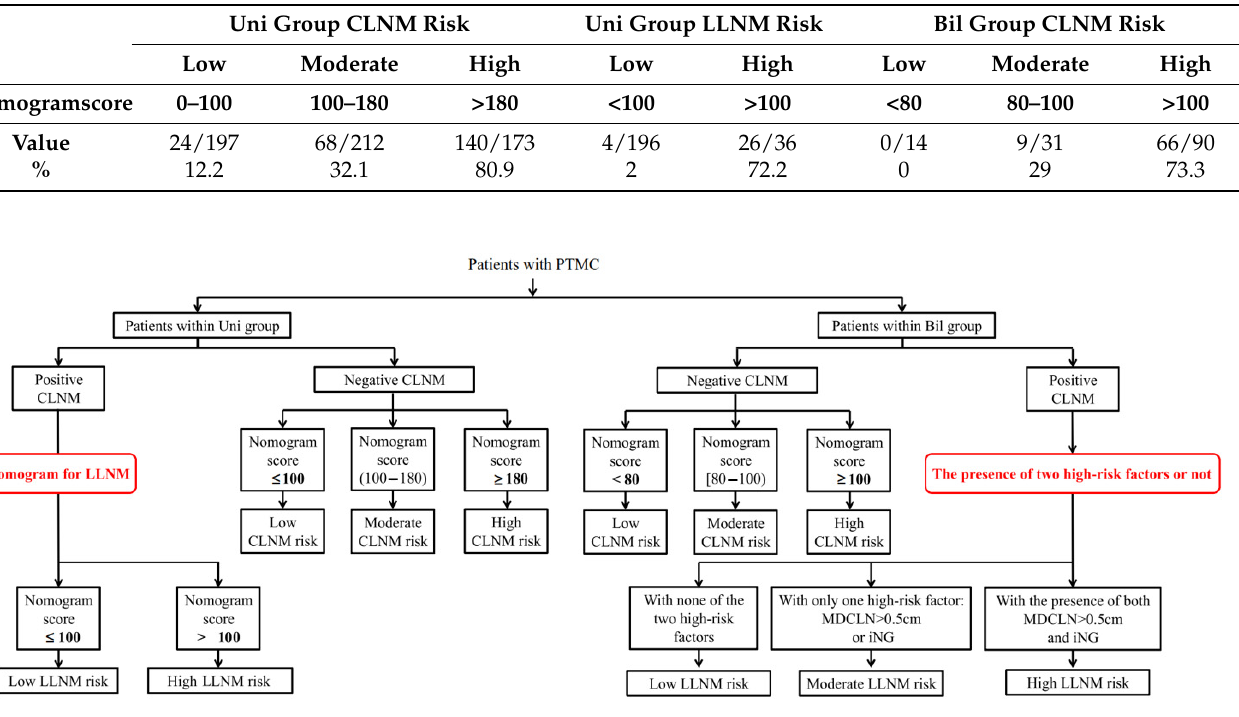
Figure 3. A flow chart of cervical lymph node metastasis risk including both CLNM and LLNM for PTMC patients with unilateral and bilateral diseases. CLNM, central lymph node metastasis; LLNM, lateral lymph node metastases; PTMC, papillary thyroid microcarcinoma; iNG, ipsilateral nodular goiter.